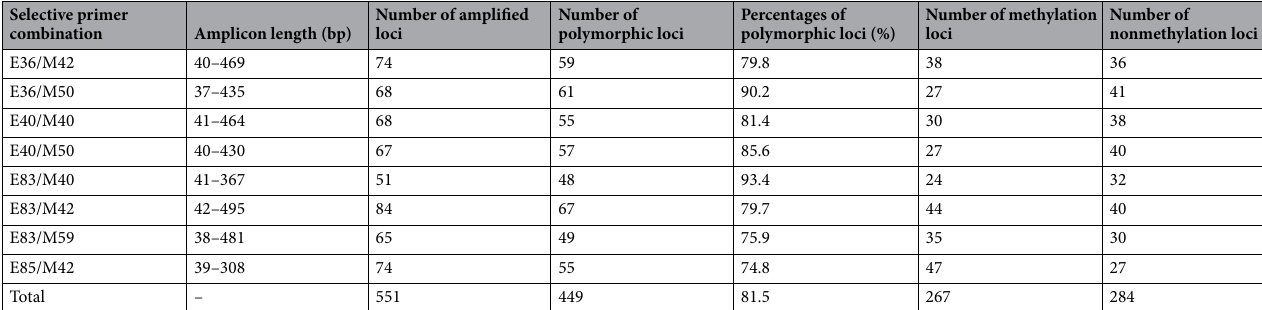
Table 1. Number of loci across eight pairs of selective primer combinations with respective methylation loci, nonmethylation loci and percentages of polymorphic